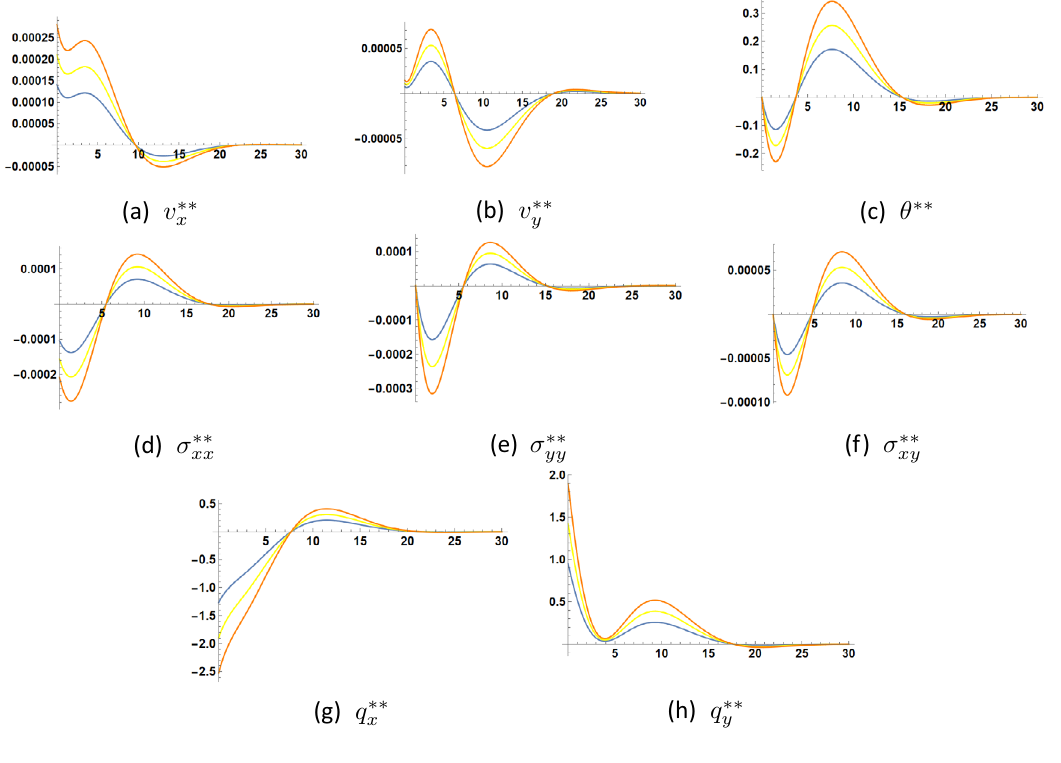
Figure 4. Second order solution as function of y at x = 0.1 , t = 1.5 for three values of η . • η = 1 • η = 1.5 • η = 2 .